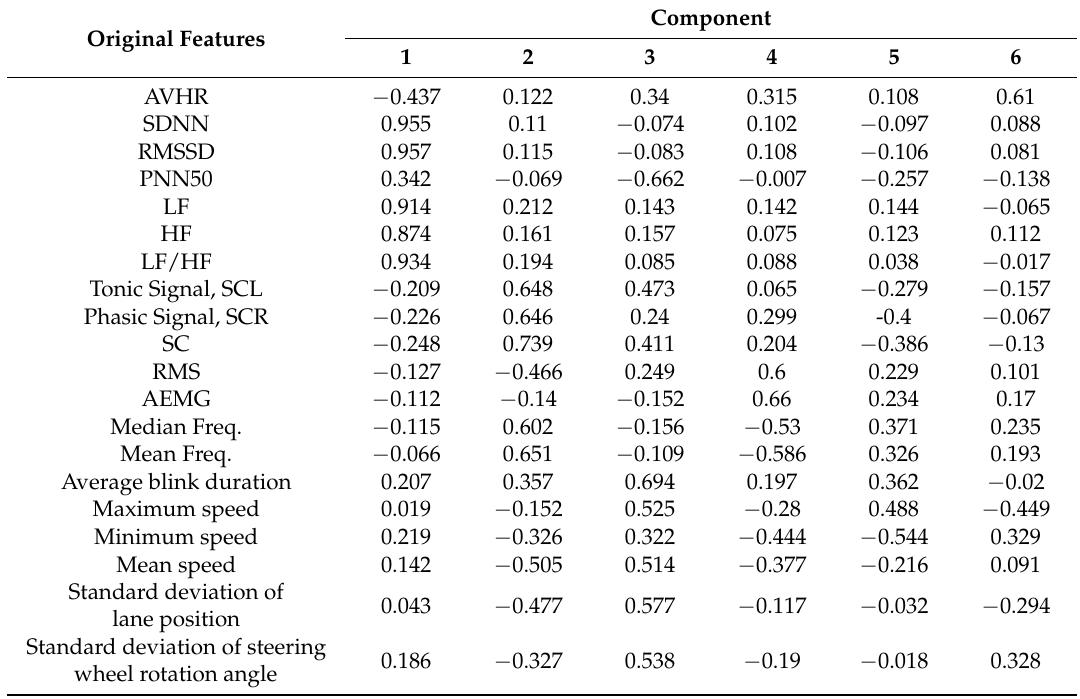
Table 3. Component